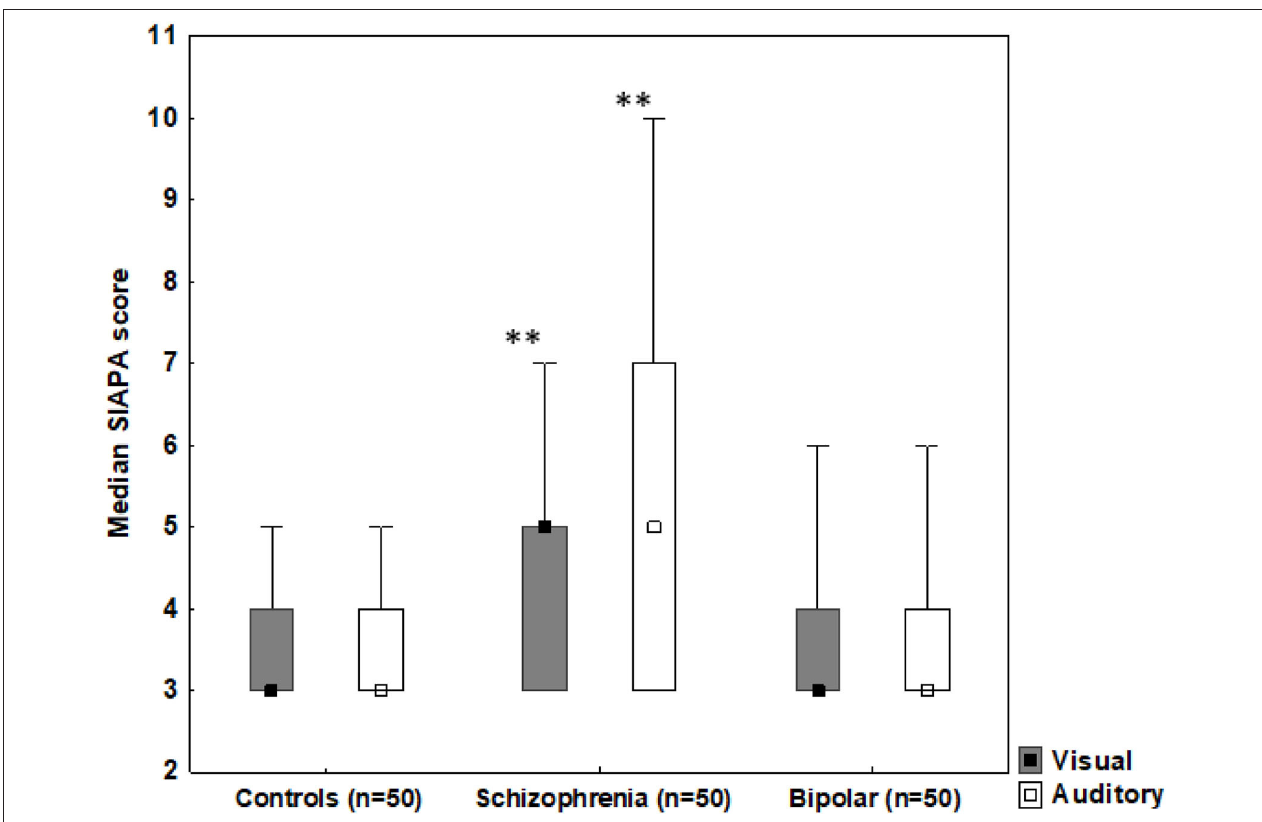
FIGURE 3 | Median SIAPA (Structured Interview for Assessing Perceptual Anomalies) scores from the visual and auditory modalities. Error bars indicate range, boxes indicate 25–75% percentiles. ** p < 0.001, schizophrenia patients outscoring controls and patients with bipolar disorder in both visual and auditory